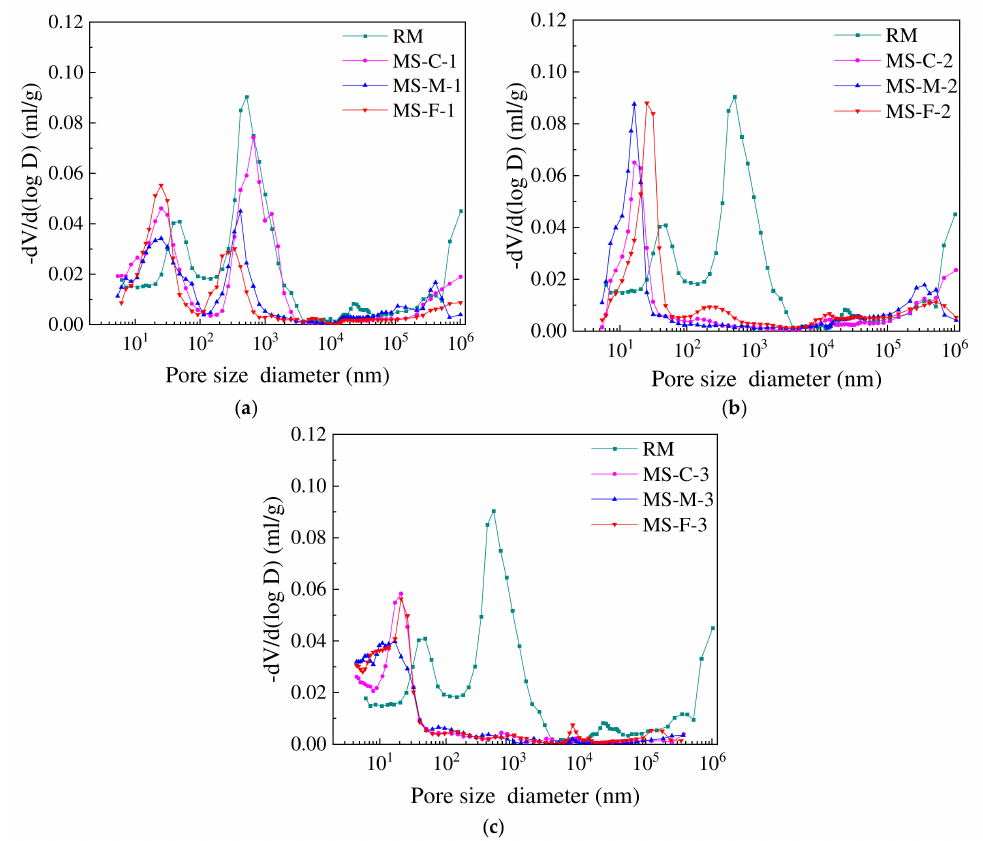
Figure 9. Differential pore size of the HPC distribution curve. ( a ) Single FA; ( b ) Double mixing FA and SF; ( c ) Three admixtures of FA, SF, and